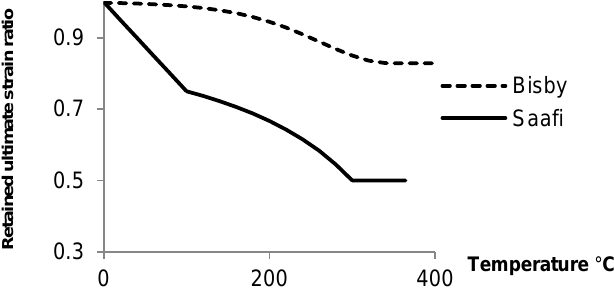
Figure 4. Comparison of the models proposed by Bisby and Saafi for ultimate strain of GFRP bars at elevated